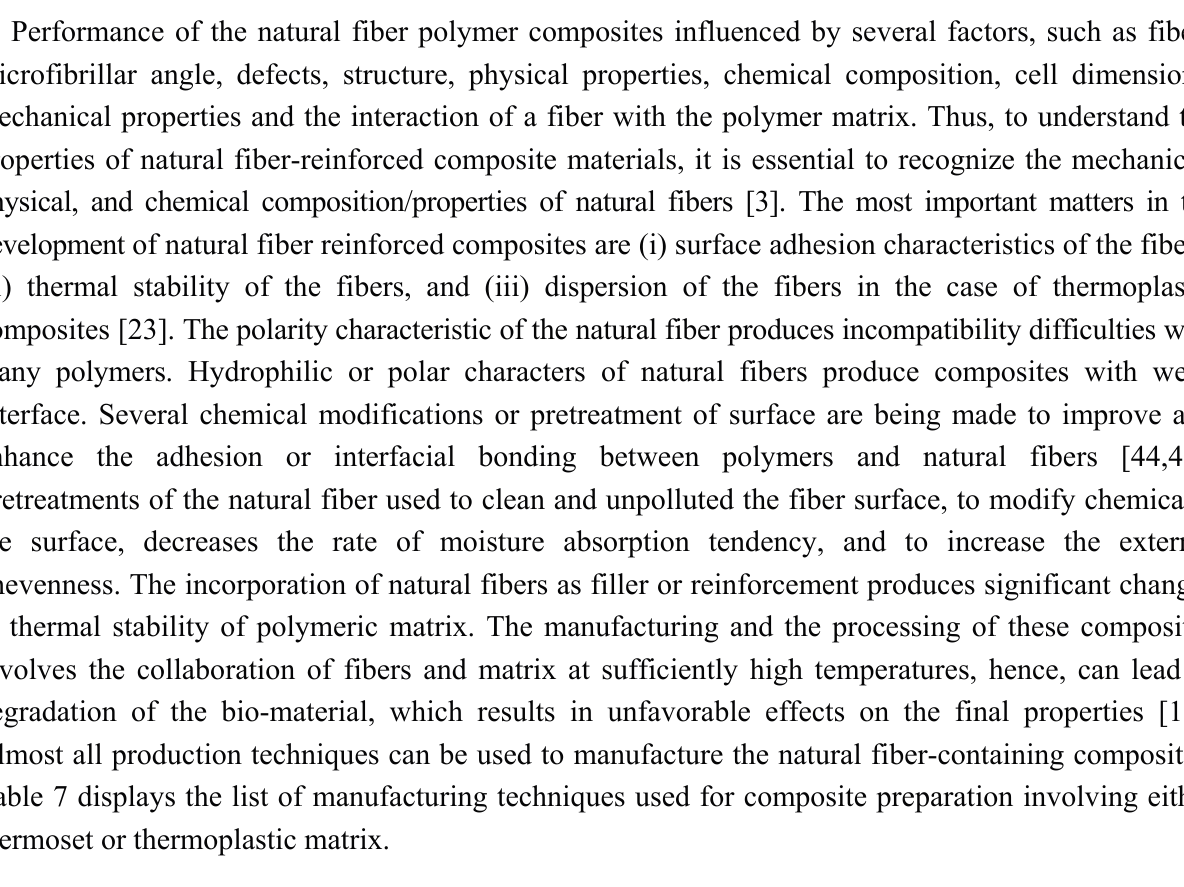
Table 7. Techniques for the composite preparation with the